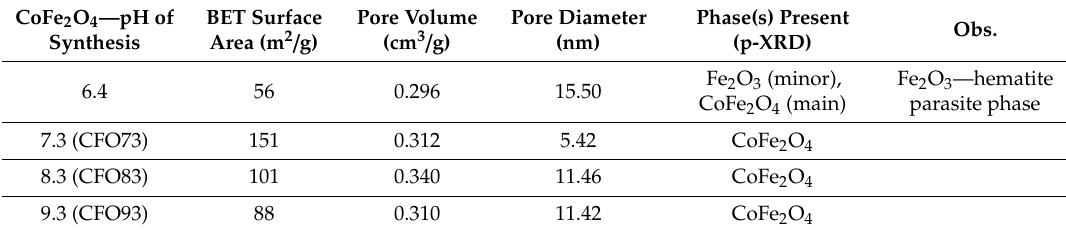
Table 1. Morphological characteristics of as-synthesized cobalt ferrite CoFe 2 O